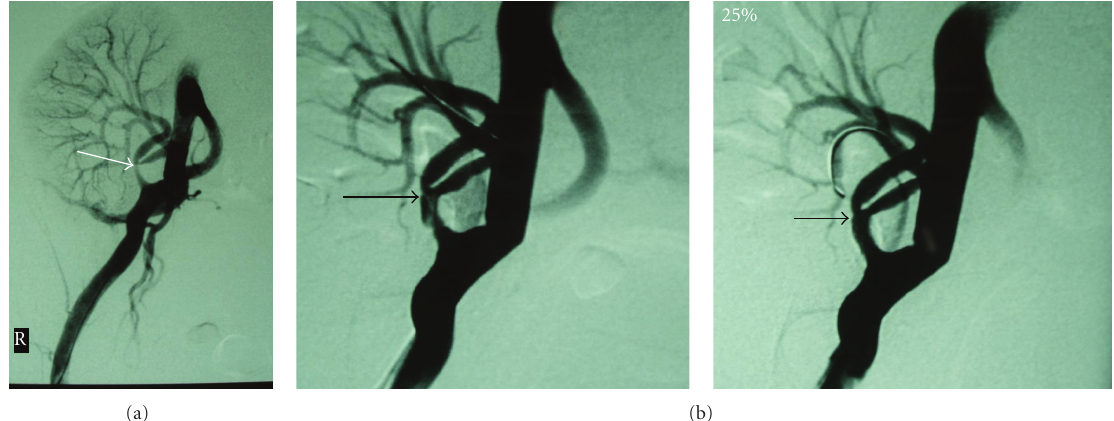
Figure 1: (a) Transplant renal artery stenosis at the bifurcation, a ff ecting mostly the inner ramus (arrow). (b) Left. Postballoon angioplasty; dilatation of the segmental renal artery with dissection of the main renal artery lumen (arrow). Right. Image Postballoon expandable stent placement (arrow).